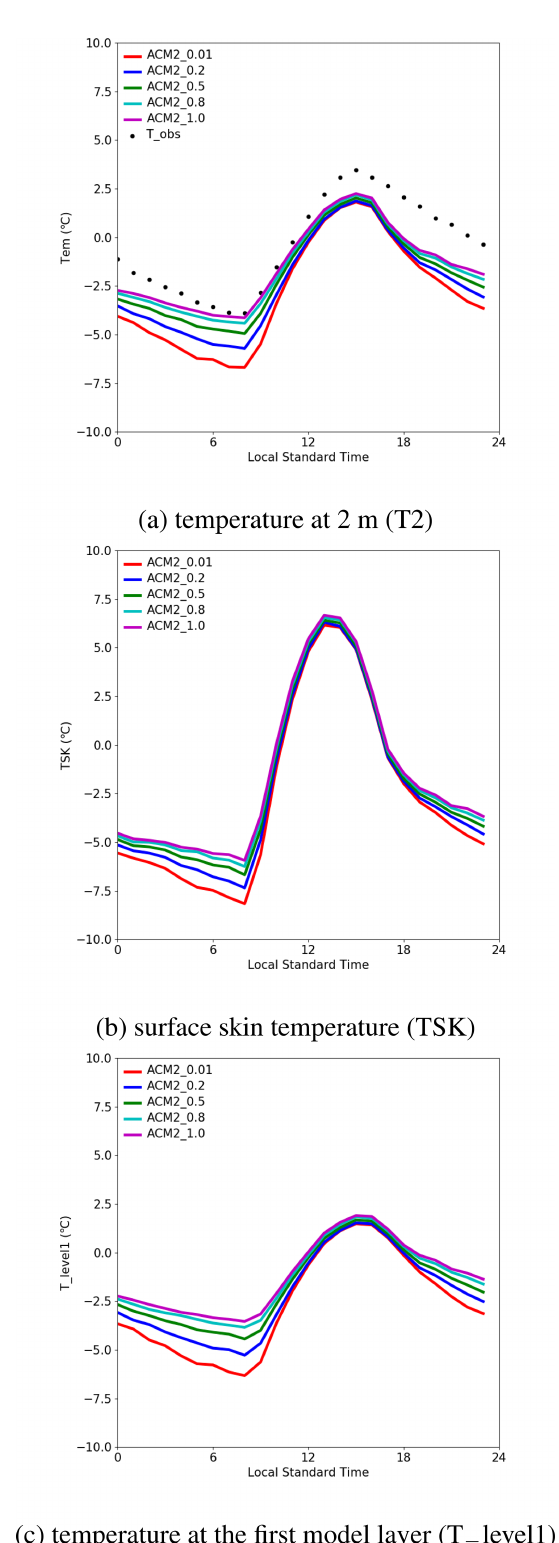
Figure 2. Diurnal mean time series of (a) the temperature at 2m (T2), (b) the surface skin temperature (TSK), and (c) the temper- ature at the first model layer (T_level1) predicted by the ACM2 scheme with different K z min constant